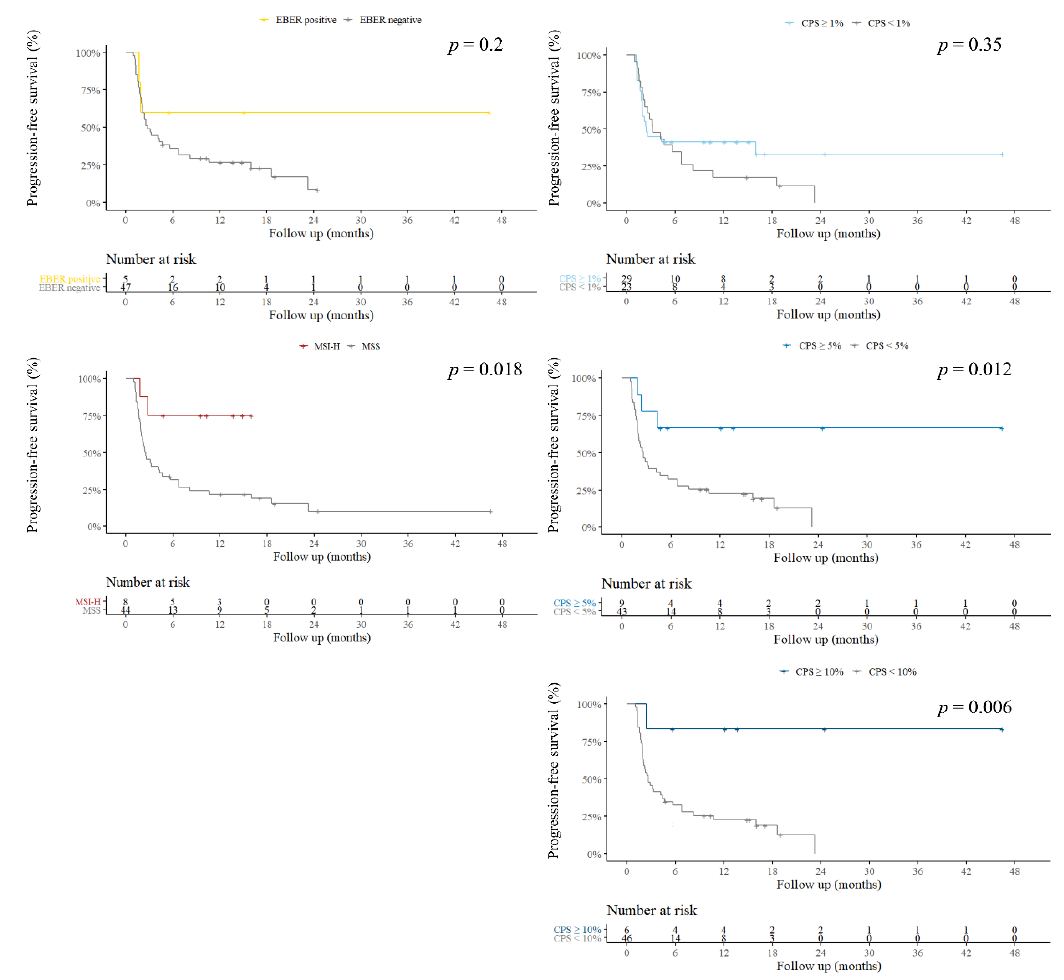
Figure 3. Survival analysis in patients with and without each biomarker. CPS: combined positive score; EBER: Epstein–Barr virus (EBV)-encoded small RNAs; MSI-H: high microsatellite instability; PD-L1: programmed death ligand 1. Table 3. Outcomes of patients with different cut-off levels of PD-L1